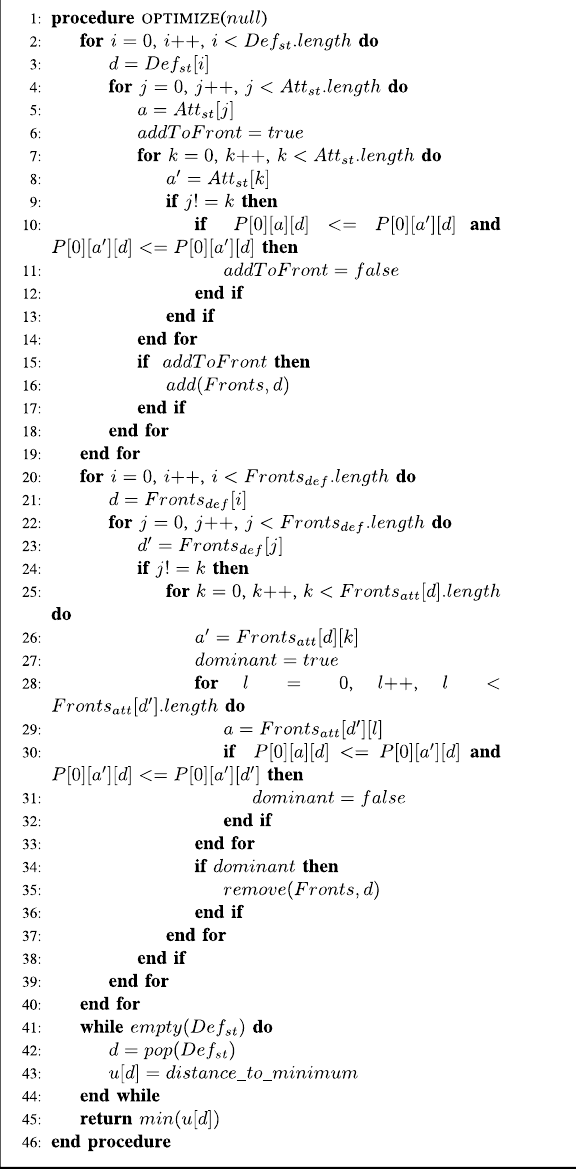
Electronics 2018 , 7 , x FOR PEER REVIEW